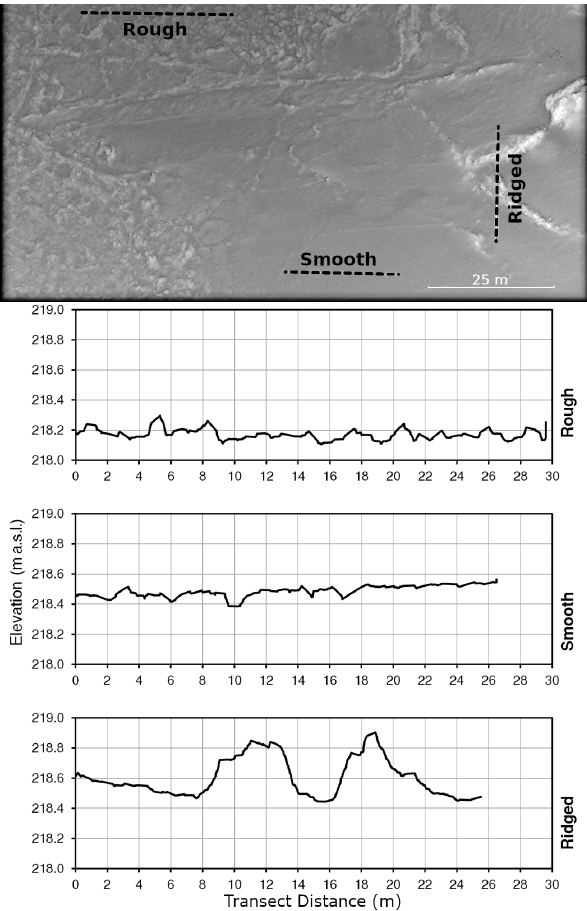
Figure 8. Examples of three types of roughness observed in ice sur- face roughness samples along the indicated transects (dotted lines) at DRLL08a, 13 November